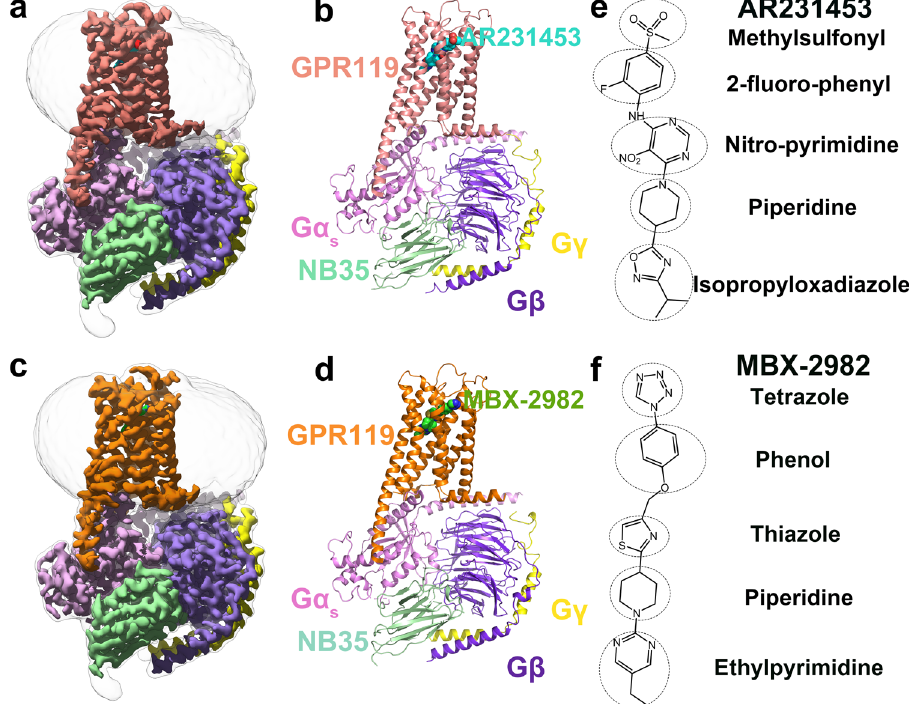
Fig. 1 | Overall cryo-EM structures of the GPR119-G s heterotrimer complexes. a , b The cryo-EM density ( a ) and the cartoon representation ( b ) of the AR231453- GPR119- G s complex. GPR119, AR231453, Ga s , G β , G γ , Nb35 are colored pink, cyan, light purple, purple, yellow, light green, respectively. c, d , The cryo-EM density ( c )